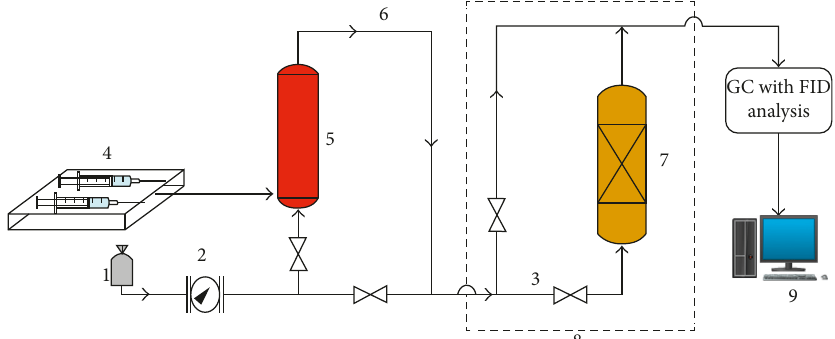
Figure 1: Schematic diagram of experimental unit for adsorption of VOCs vapors over activated carbon. (1) Feed nitrogen; (2) mass flow controller; (3) pure N2 stream; (4) syringe pump; (5) evaporator column; (6) main stream; (7) adsorption column; (8) thermostatic enclosure; (9) gas chromatography; (10) acquisition